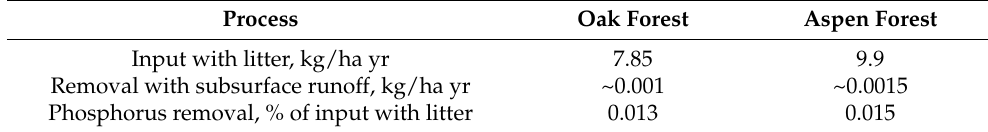
Table 6. Phosphorus input with litter and removal with subsurface runoff in forest biogeocenoses [26]. Process Oak Forest Aspen Forest Input with litter, kg/ha